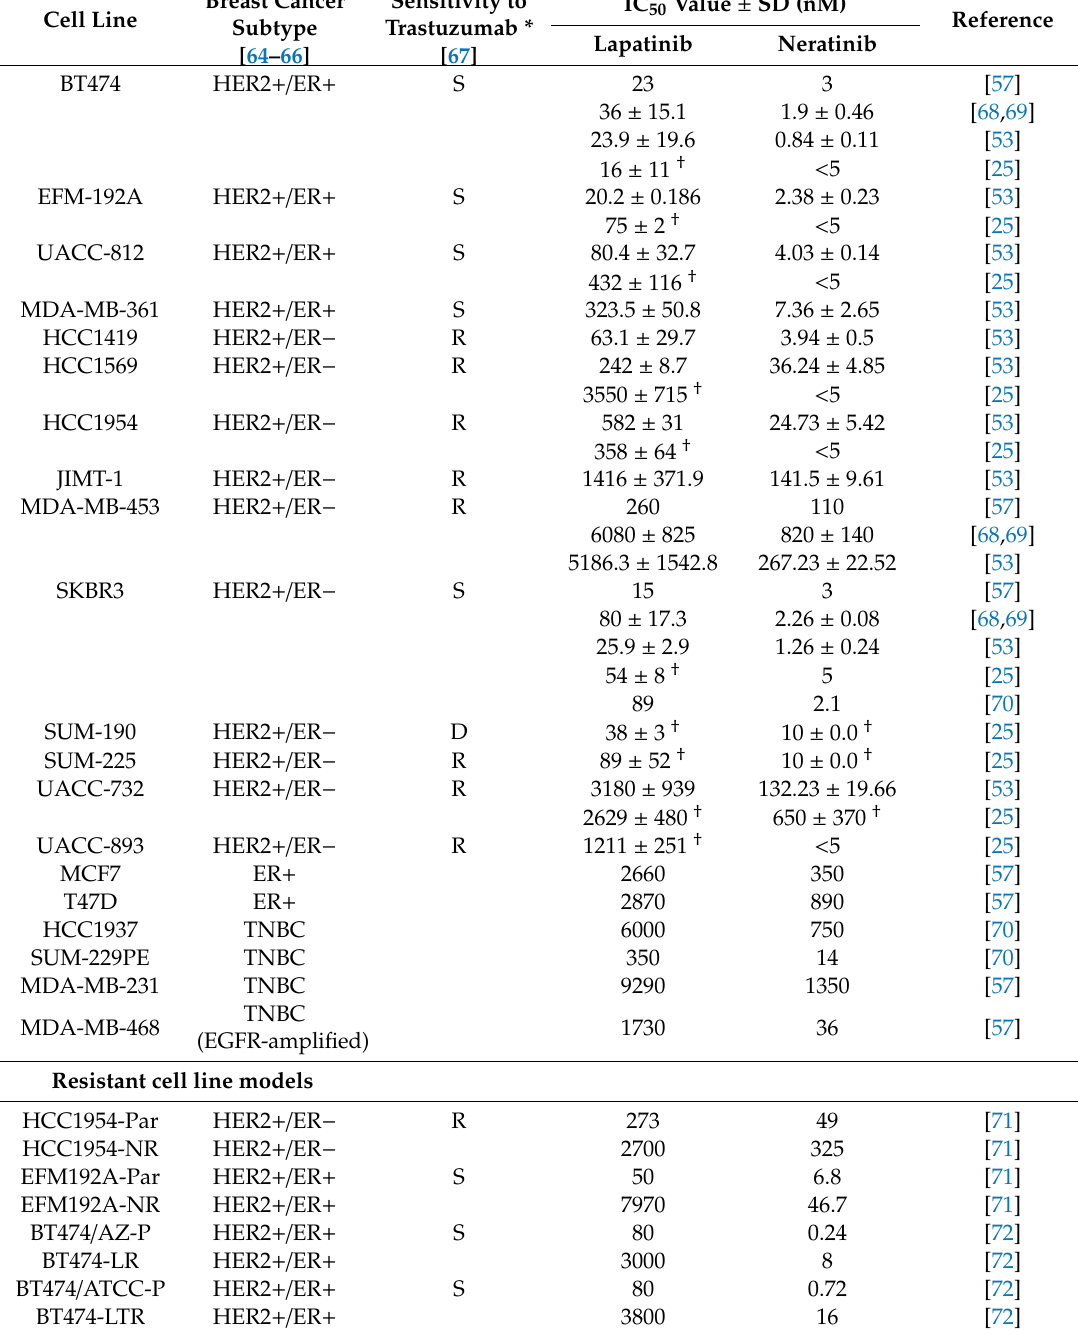
Table 2. IC 50 values for lapatinib and neratinib in cell-based assays: therapy-naive and targeted therapy-resistant cell